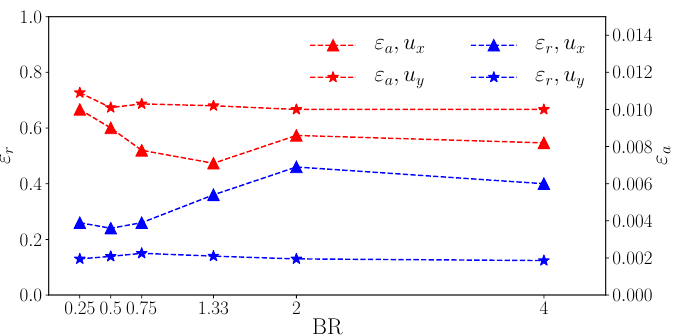
Figure A6. Absolute ( ε a ) and relative ( ε r ) errors versus BR for the asymmetric canyons. ε a is normalised by U ref (see Equation (4)).